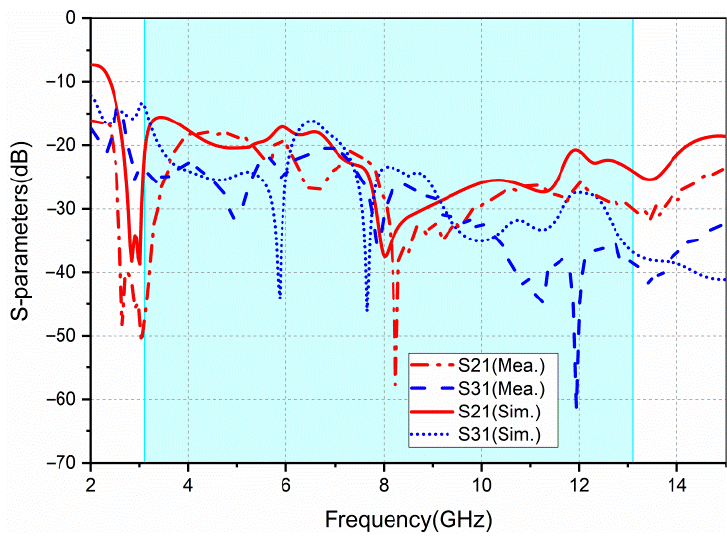
Figure 8. Simulated and measured return loss (S11).